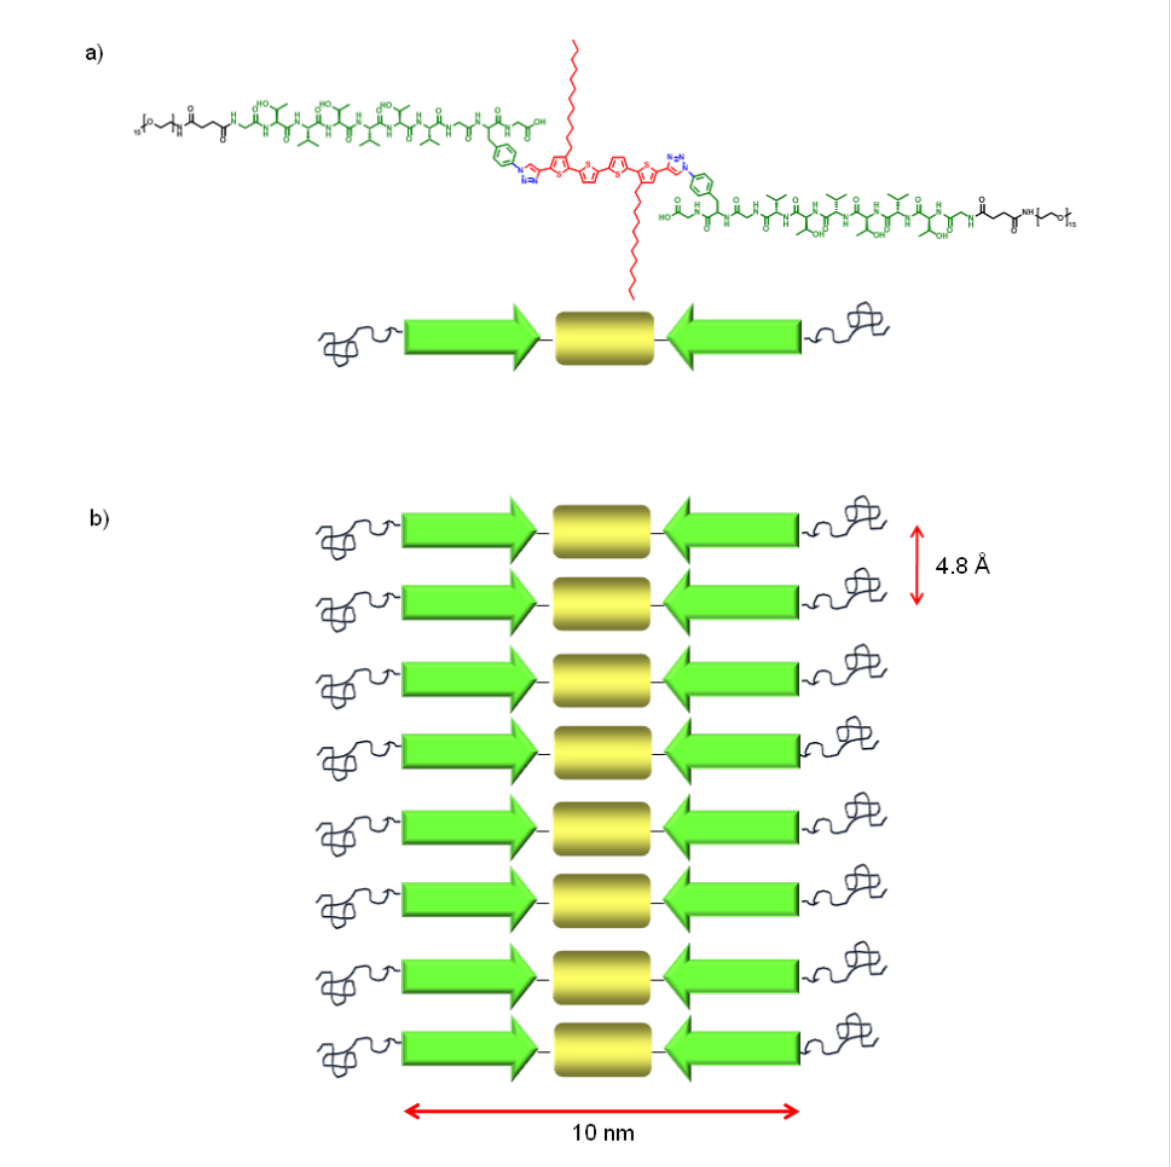
assumed based on the data available. Such multilayer β -sheets